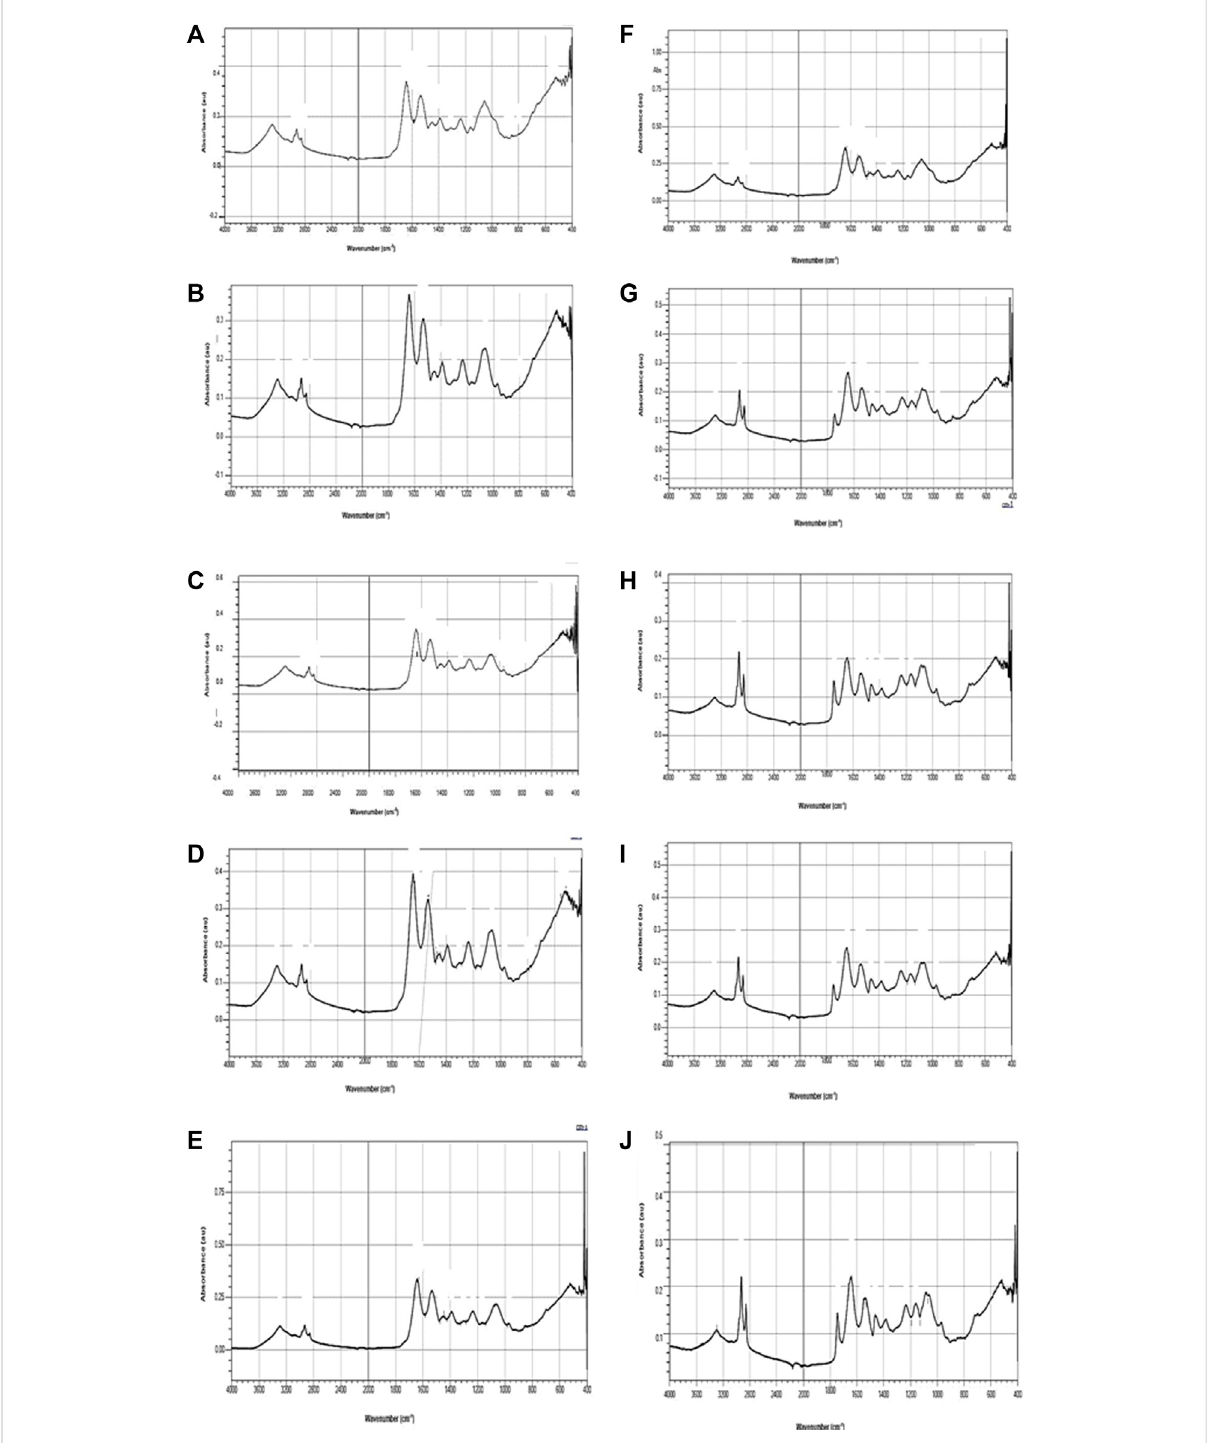
FIGURE 6 FT-IR spectra of L. rohita hatchlings after 96 h exposure (A – E) to TCS and 10 days of the recovery period (F – J) . Control (A , F) , acetone (B , G) , 0.06 mg/L (C , H) , 0.067 mg/L (D , I) , 0.097 mg/L (E , J)